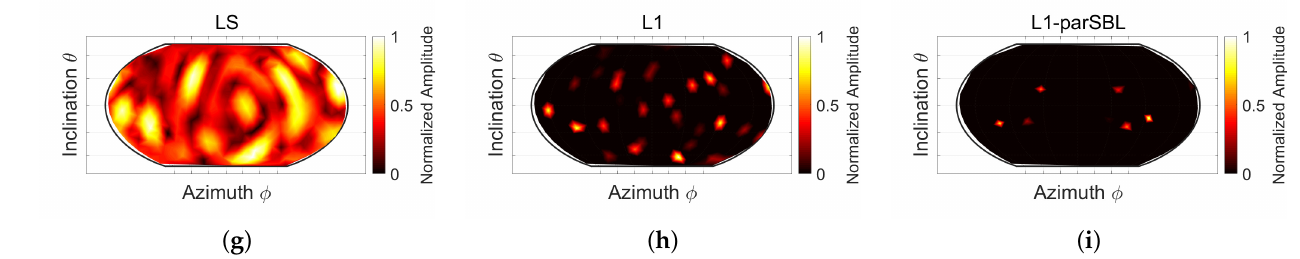
Figure 10. (Color online) Estimated PWs under different SNRs for the mode at approximately 106.5 Hz when using LS, L1, and L1-parSBL ( R = 400). ( a – c ) SNR = 30 dB. ( d – f ) SNR = 20 dB. ( g – i ) SNR = 10